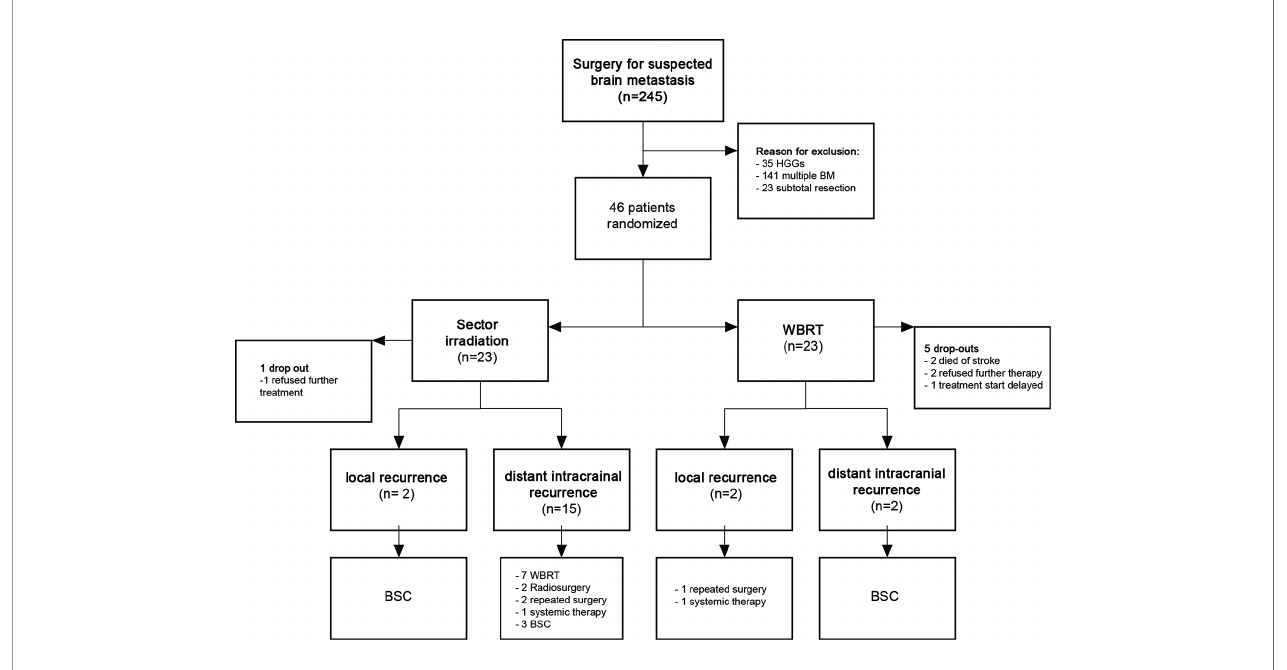
FIGURE 1 | Treatment